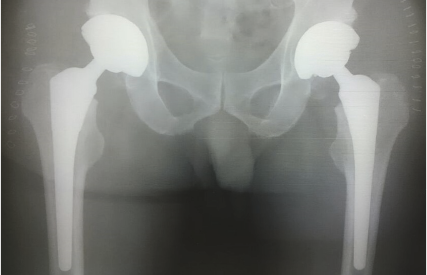
Figure 2: Postoperative anteroposterior